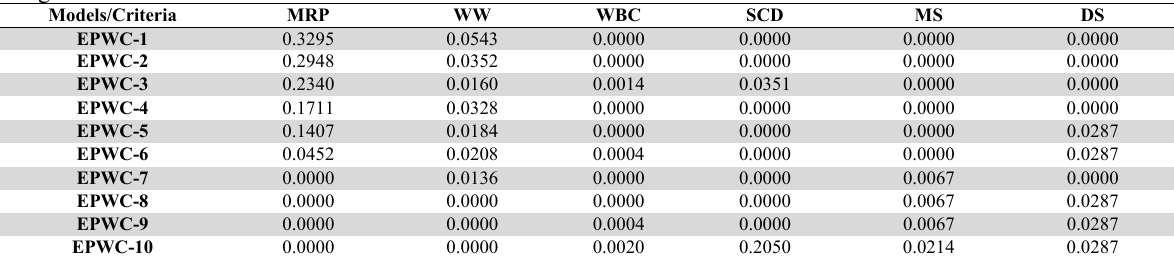
Weighted PDA for EPWC selection Models/Criteria